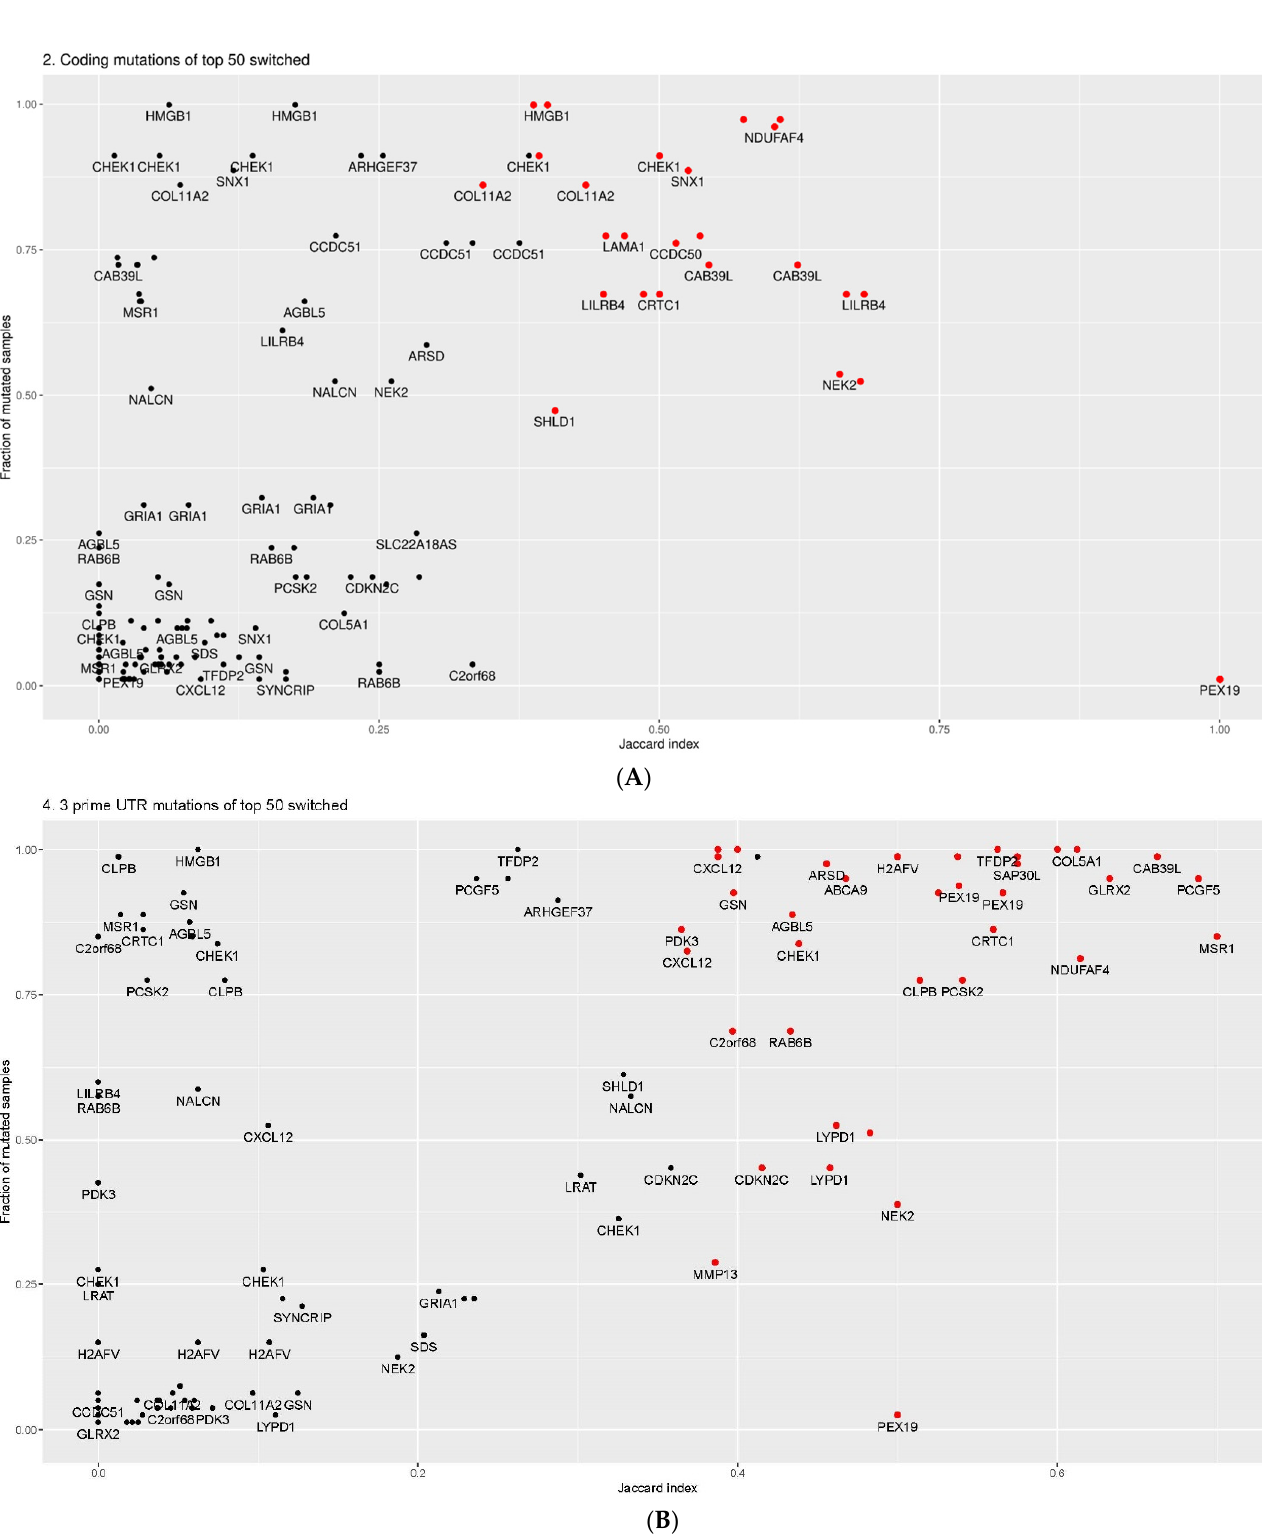
Figure 11. Jaccard index plots for the association of isoform switches with mutations . ( A ) Jaccard index (x axis) for coding mutations with switched isoforms of top 50 switched genes against frequency of mutated samples (y axis). ( B ) Jaccard index plot for mutations located in 3 ′ UTR. Z-score for calculated J index was estimated by constructing a distribution of Jaccard indices of 200 randomly selected switched isoforms of similar length. Z-score by comparing the actual J-value with the J index of 200 different switched isoforms of similar length from melanoma vs. nevus comparison. Each dot corresponds to one isoform and is labeled with its gene name. Significant genes with Z-scores above 1.6 are marked as red ( p < 0.05).